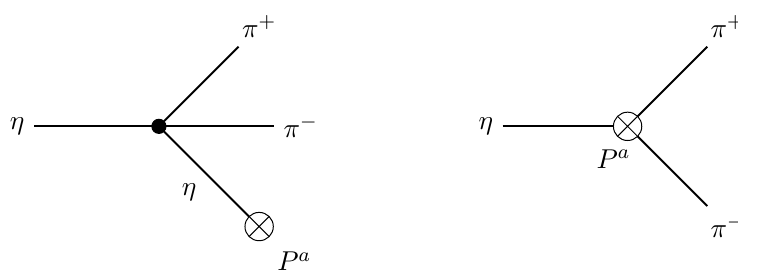
Figure 1 . Leading-order (LO) Feynman diagrams for h π + π − | P a | η i in χ